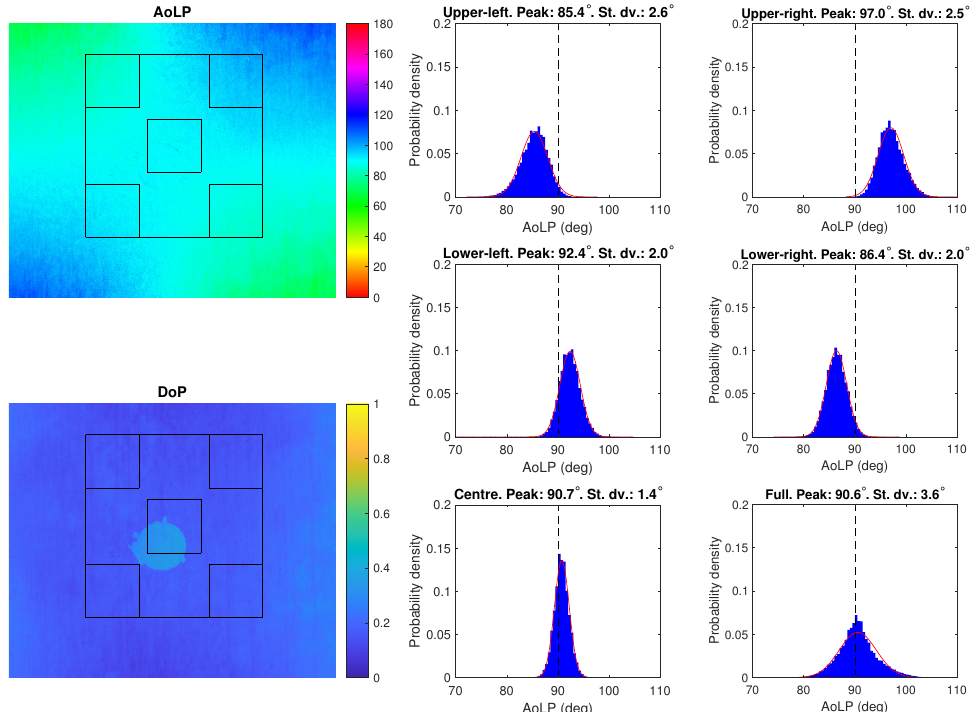
Figure 21. Results for the cured UD sample taken for Figure 9 but under dome illumination with a 12 mm lens. The spot near the centre of the DoP image is a result of the hole in the dome for the